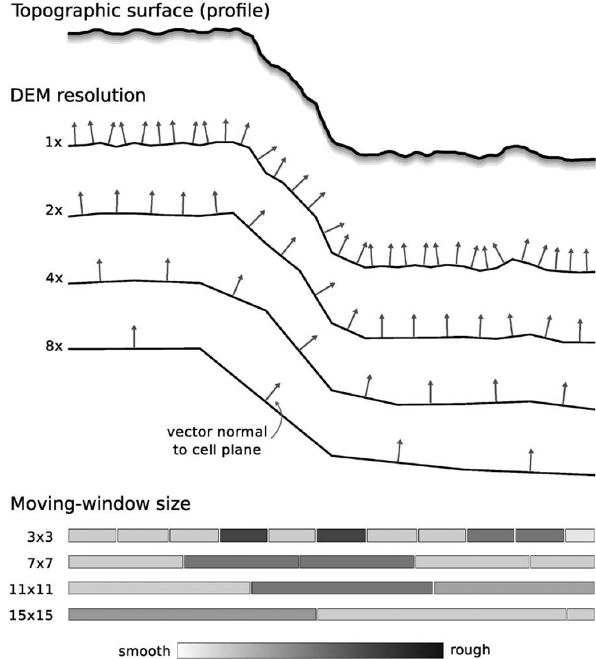
Figure 5. Vector dispersion method used to calculate surface rough- ness at different scales for a topographical surface. Graphic from Grohmann et al.